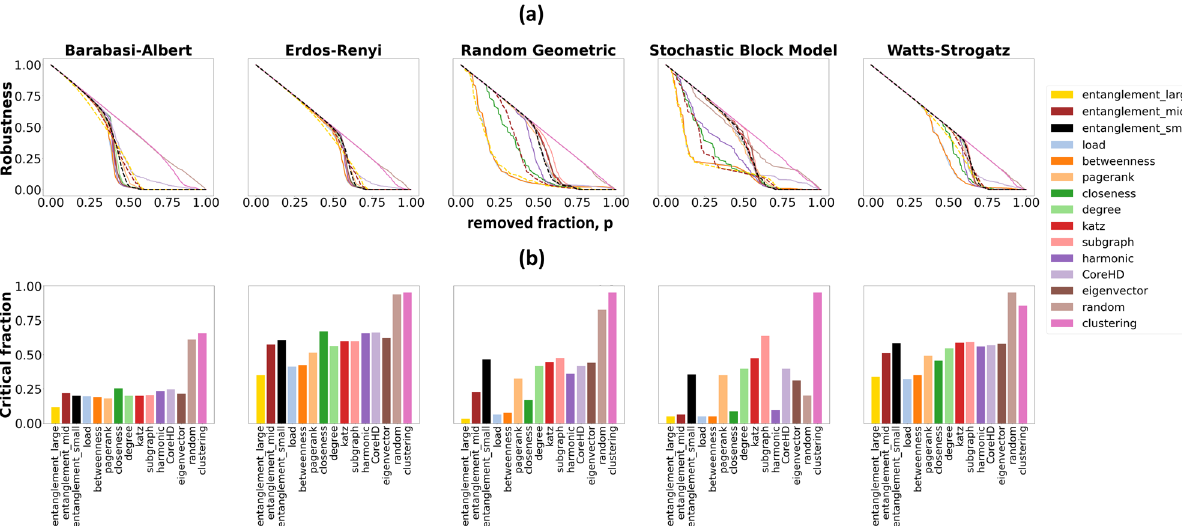
Fig. 4 Robustness analysis of synthetic networks, using adaptive centrality measures. Disintegration of different network topologies, including Barabasi – Albert, Erd ő s – Rényi, random geometric, stochastic block model, and Watts – Strogatz models is considered. The robustness of an ensemble of each network model is tested against random failures and targeted attacks based measures of node centrality including betweenness, load, clustering, eigenvector, PageRank, closeness, current fl ow closeness, harmonic, subgraph, degree, and entanglement at three temporal scales (-small, -mid, -large), the last one introduced in this study and represented by dashes for more clarity ( a ). In contrast with Fig. 3, here, all these centrality measures are used in adaptive fashion — i.e., the ranking of the nodes according to every measure is updated after each node removal. Similar to the static analysis, the entanglement centrality, tuned at relatively large propagation time-scale, performs equal or faster than other measures in breaking the network up to its critical fraction ( b ). Except for entanglement at small and middle scales, the centrality measures presented in the boxes at the bottom are ordered according to the overall performance of the considered measures, across all numerical